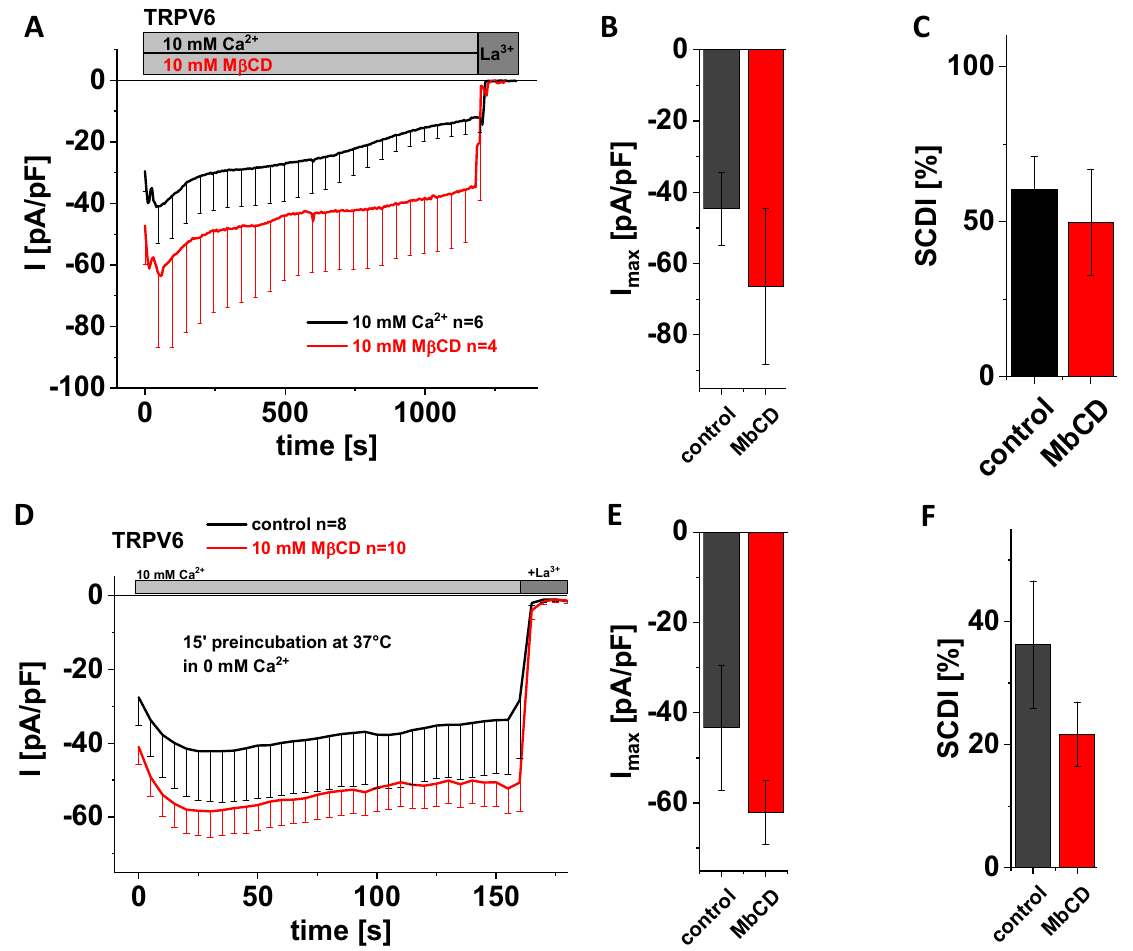
Figure 4. Application of M β CD has no effect on maximum currents and SCDI of TRPV6 WT. ( A ) Averaged time course of whole-cell currents (mean ± SEM) recorded from HEK293 cells express- ing TRPV6 WT. Measurements were carried out in 10 mM Ca 2+ extracellular solution with (red) or without (control, black) 10 mM M β CD and currents were blocked by 1 mM La 3+ at the end of the experiments, as indicated by the grey bars. ( B ) Block diagram of maximum currents according to measurements in ( A ). ( C ) Block diagram of the extent of SCDI in % according to measurements in ( A ). ( D ) Averaged time course of whole-cell currents (mean ± SEM) recorded from HEK293 cells expressing TRPV6 WT. Cells were preincubated in 0 mM Ca 2+ extracellular solution with (red) and without (control, black) 10 mM M β CD at 37 ◦ C for 15 minutes. Measurements were carried out in 10 mM Ca 2+ extracellular solution and currents were blocked by 1 mM La 3+ at the end of the experiments, as indicated by the grey bars. ( E ) Block diagram of maximum currents according to measurements in ( D ). ( F ) Block diagram of the extent of SCDI in % according to measurements in ( D ). There is no statistical significance ( p < 0.05) in comparison to TRPV6